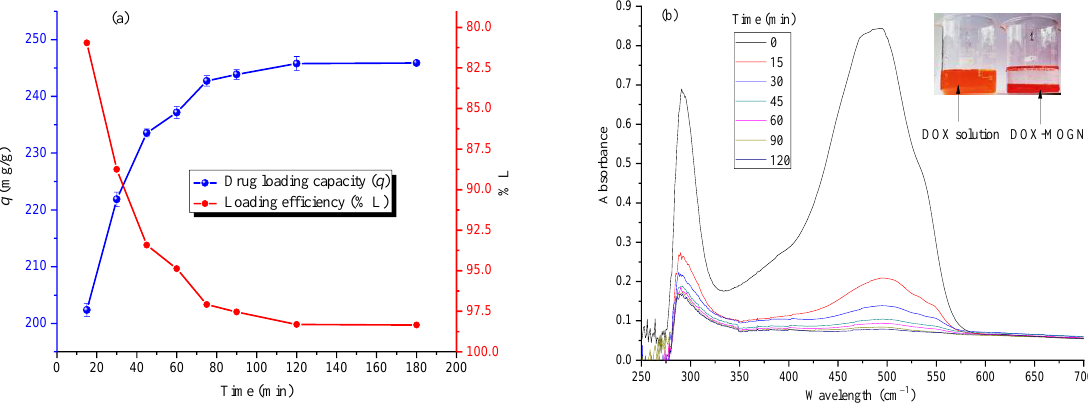
Figure 7 . Drug loading capacity (q) and loading efficiency (%L) of DOX onto MOGN at 37 °C with time ( a ) and UV–spectrum of DOX loading onto MOGN with time (inset image of 250 mg/L DOX solution and DOX-loaded on MOGN) ( b ).